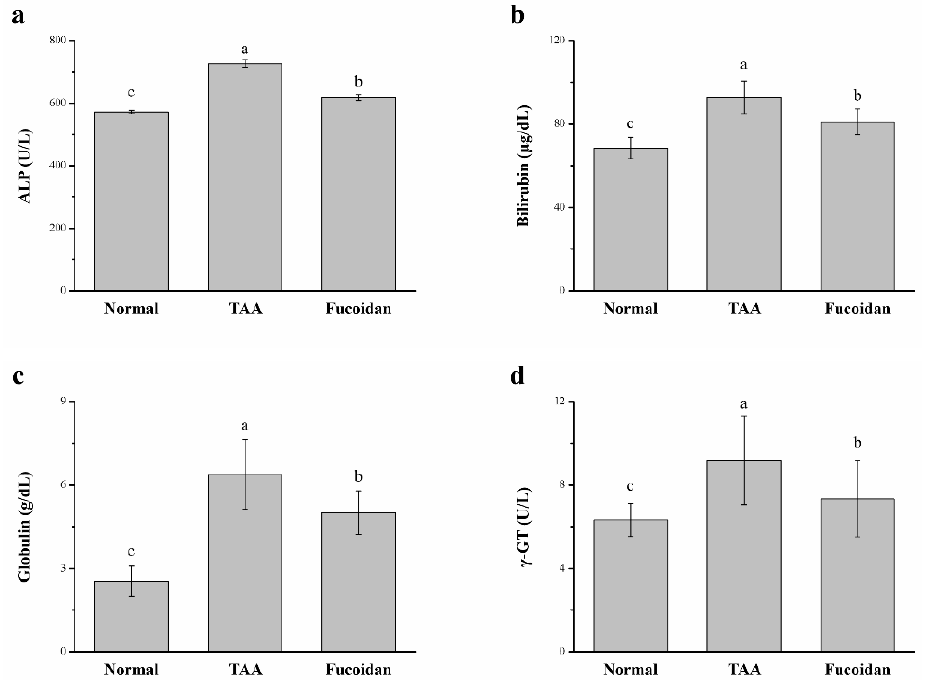
Figure 3. Changes of the serum ( a ) alkaline phosphatase (ALP), ( b ) bilirubin, ( c ) globulin, and ( d ) ( d ) γ -glutamyl transferase ( γ -GT) levels in normal mice, in mice with TAA-induced liver injury, and fucoidan-treated mice with TAA-induced liver injury over a period of 42 days. All data are presented as the means ± SEMs ( n = 10). a–c Data with different letters in the columns are significantly different with one-way ANOVA, and the means of the different groups were compared by Duncan’s test at p <